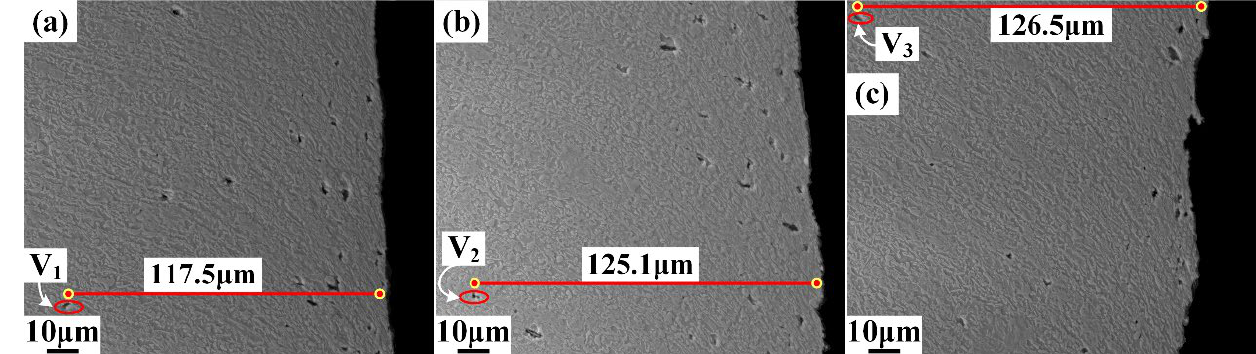
Figure 18. Farthest microvoid distributed in the sheared edge: ( a ) 5%t ; ( b ) 10%t ; ( c ) 15%t.